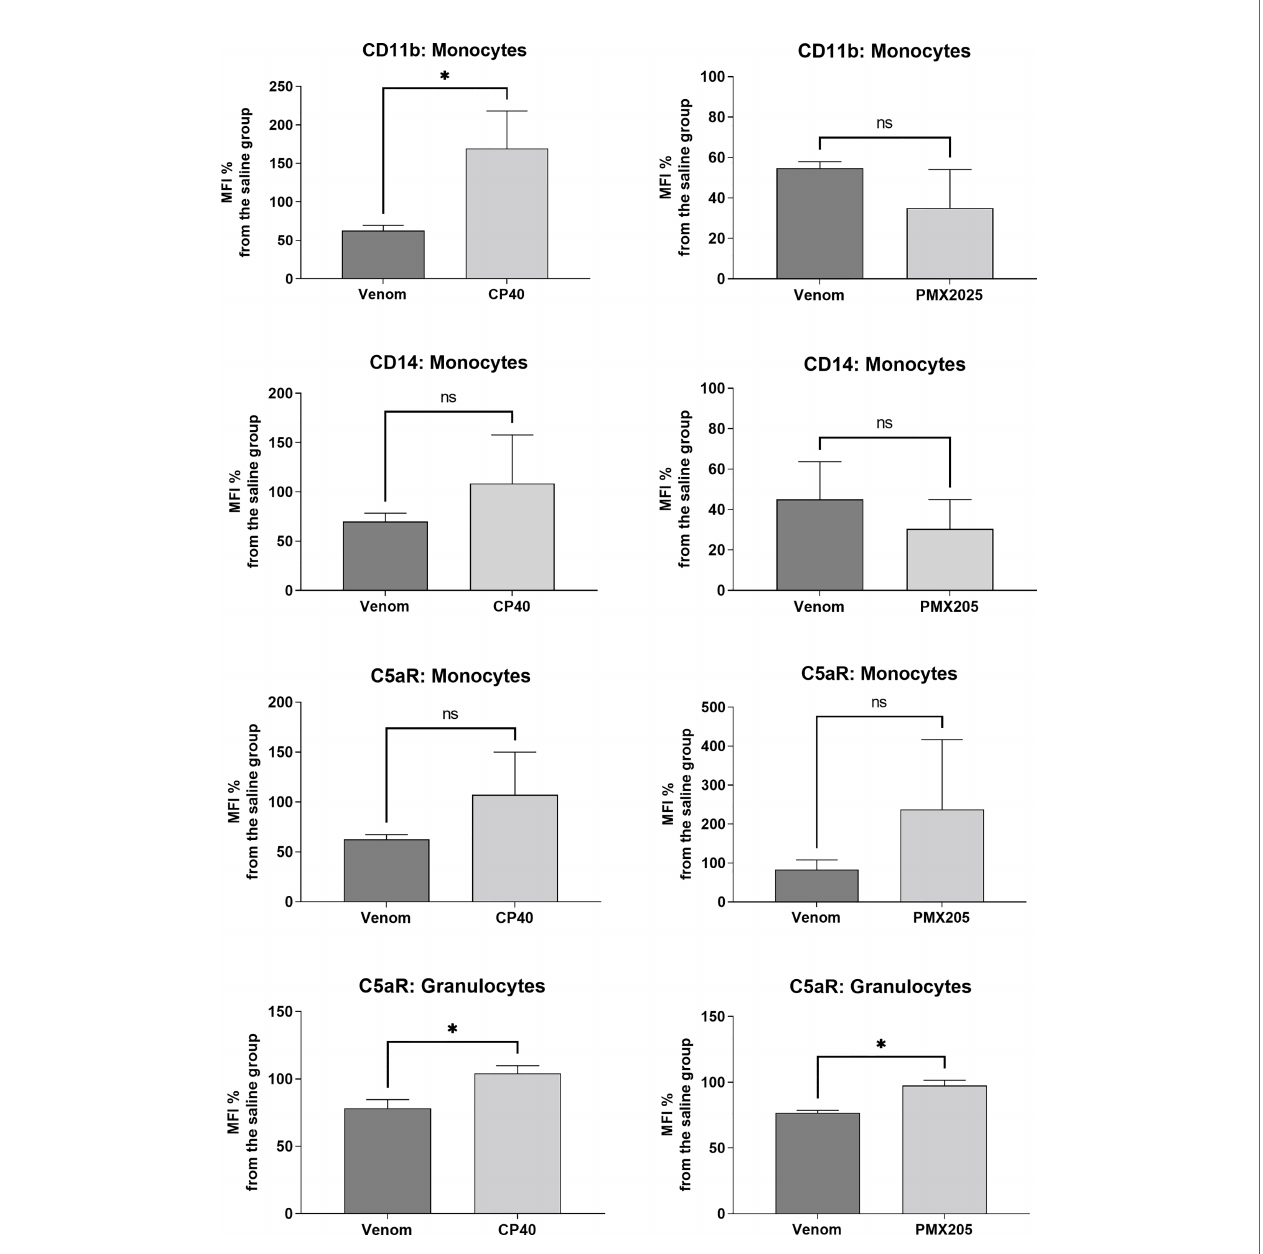
FIGURE 8 | Expression of surface markers in monocytes and granulocytes after treatment with B. jararaca venom in the presence of C-inhibitors. Human blood samples containing GPRP (8 mg/mL) were pre incubated with Cp40 inhibitor (20 m M) or with PMX205 (10 m M) and then incubated with sterile saline (Cp40 vehicle), sterile saline + 5% glucose solution (PMX205 vehicle) or B. jararaca venom (50.0 m g/mL) for 60 minutes at 37°C. After incubation, cells were analyzed for the expression of CD11b, CD14 and C5aR. The results are expressed as MFI ± SEM of duplicates from three independent experiments. ns, not signi fi cant; * p ≤